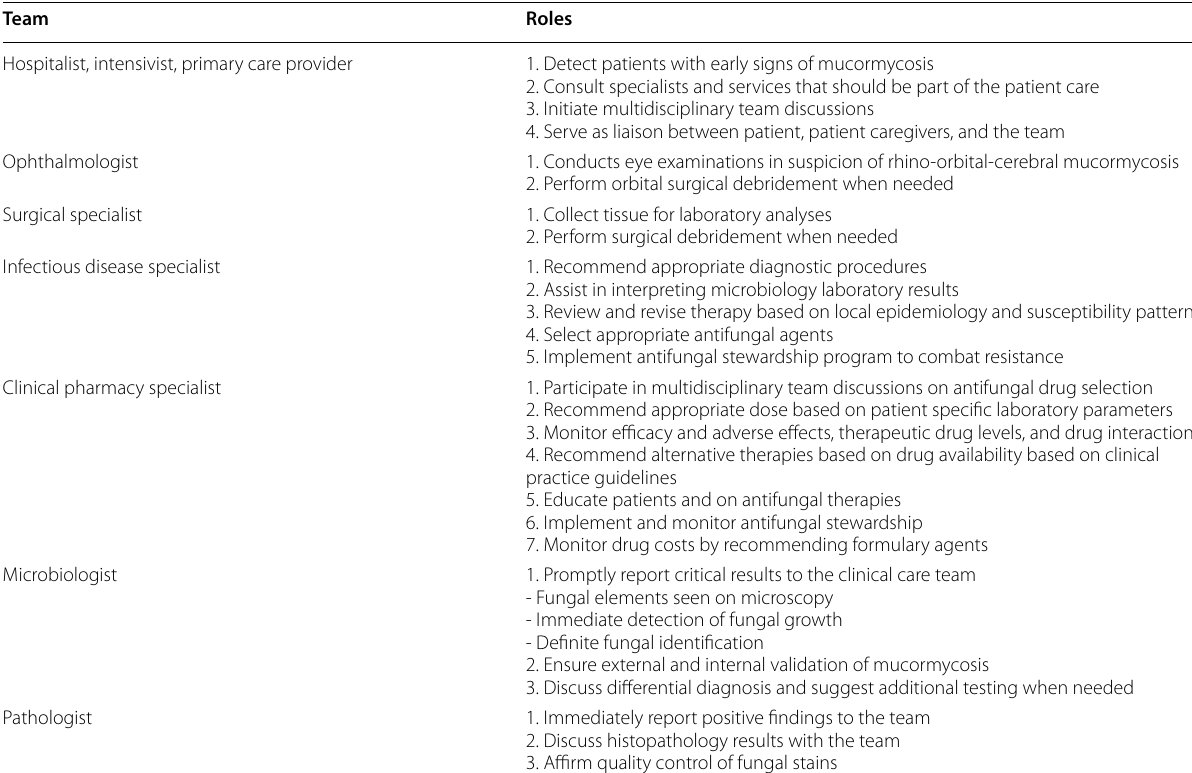
Table 2 Multidisciplinary team member roles in caring for CAM patients Team